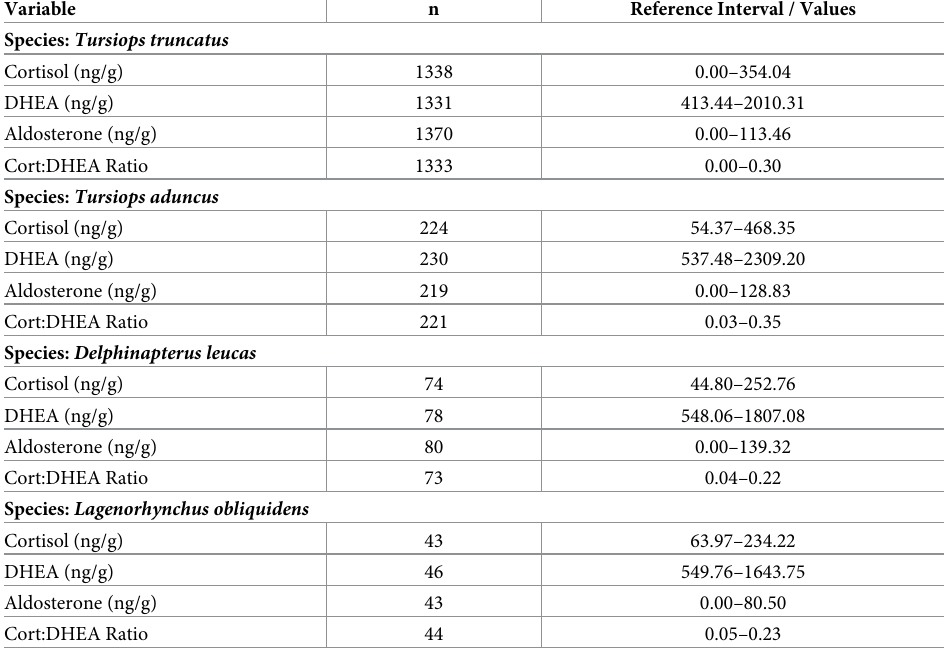
Table 5. General reference intervals or values for fecal hormone values for healthy cetaceans. General reference intervals or values (without accounting for sex, age, age 2 , and month) are given below if access to the iOS ZooPhysio- Trak app is not available for a